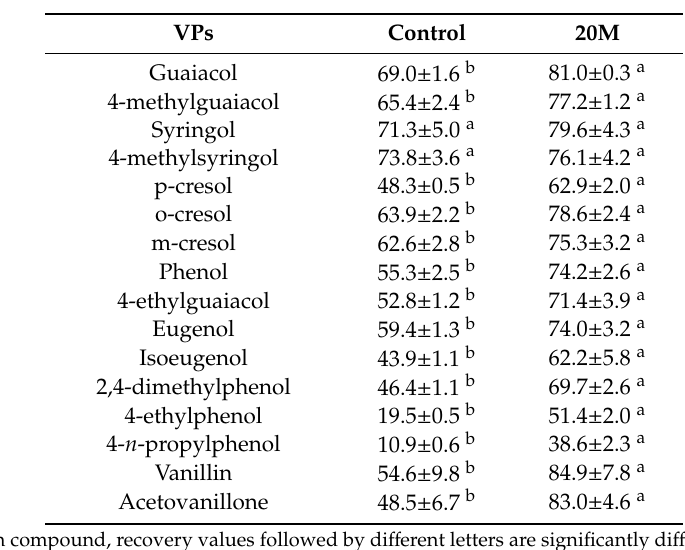
Table 2. Recovery (% ± SD, n = 3) of spiked VPs from berry homogenate with different extraction methods.